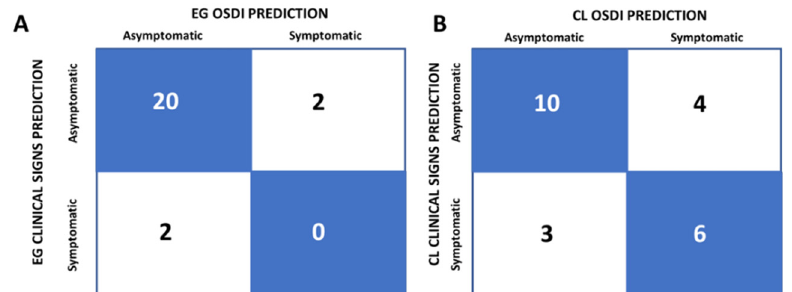
Figure 3. Confusion matrix for the classification of young eyeglasses (EG) ( A ) and contact lens (CL) ( B ) wearers as asymptomatic or symptomatic using OSDI D scores and the presence of clinical signs (reduced tear rate and/or TBUT). The number of subjects was shown inside each box.